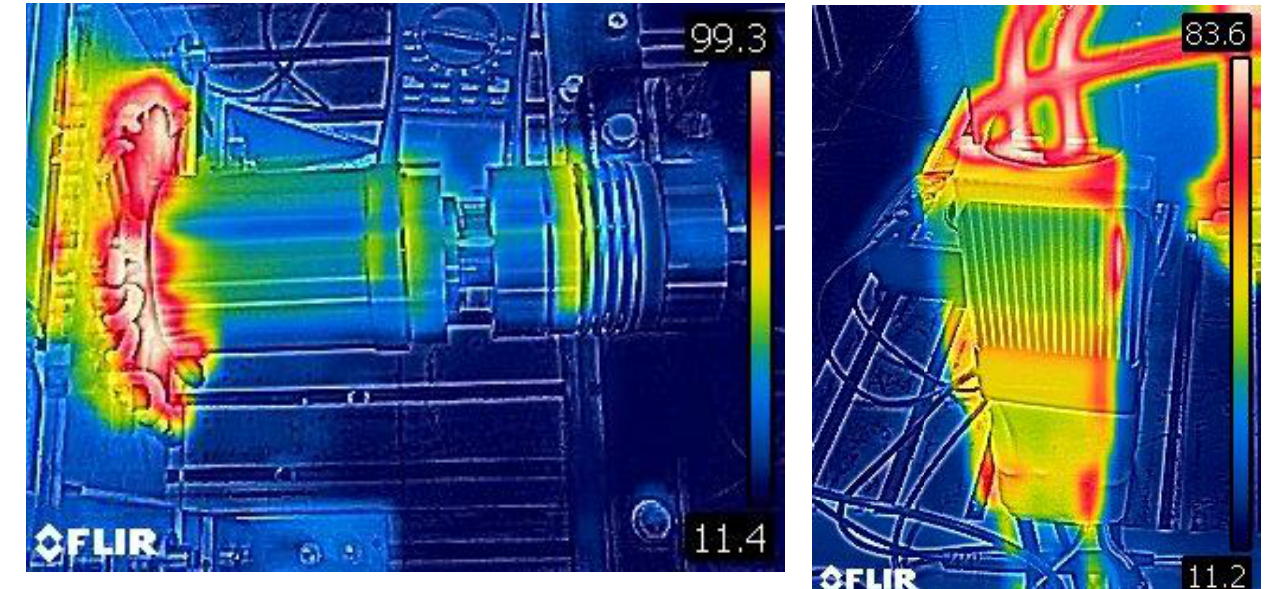
Figure 15. Heat radiation—h-configuration under I = 100 A conditions.